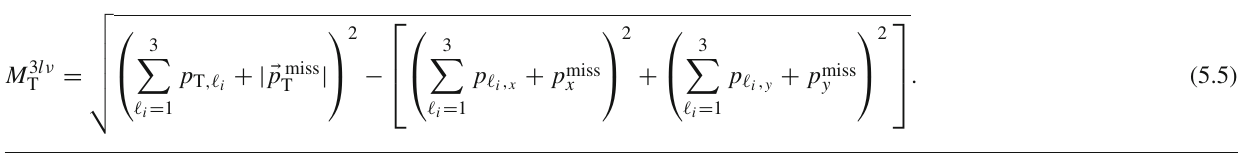
son coefficient is different from zero for each curve. From a qualitative point of view, Figs. 13 and 14 show the same , R LO , and R NLO as Figs. 7 and 8 for WW behaviour for R LO lin quad lin production. On one hand, by comparing the upper and lower panels of the left plots in Figs. 13 and 14 we conclude that terms (with the largest contribution comes from the σ LO EFT6 2 the only exception of the c W coefficient, for which the σ LO EFT6 2 terms become larger than the interference terms only in the tails of the distributions under consideration). On the other hand, comparing the left and the right plots in Figs. 13 and 14 reveals that the NLO QCD corrections tend to reduce the sen- sitivity to the aTGCs (with the exception of the c WWW